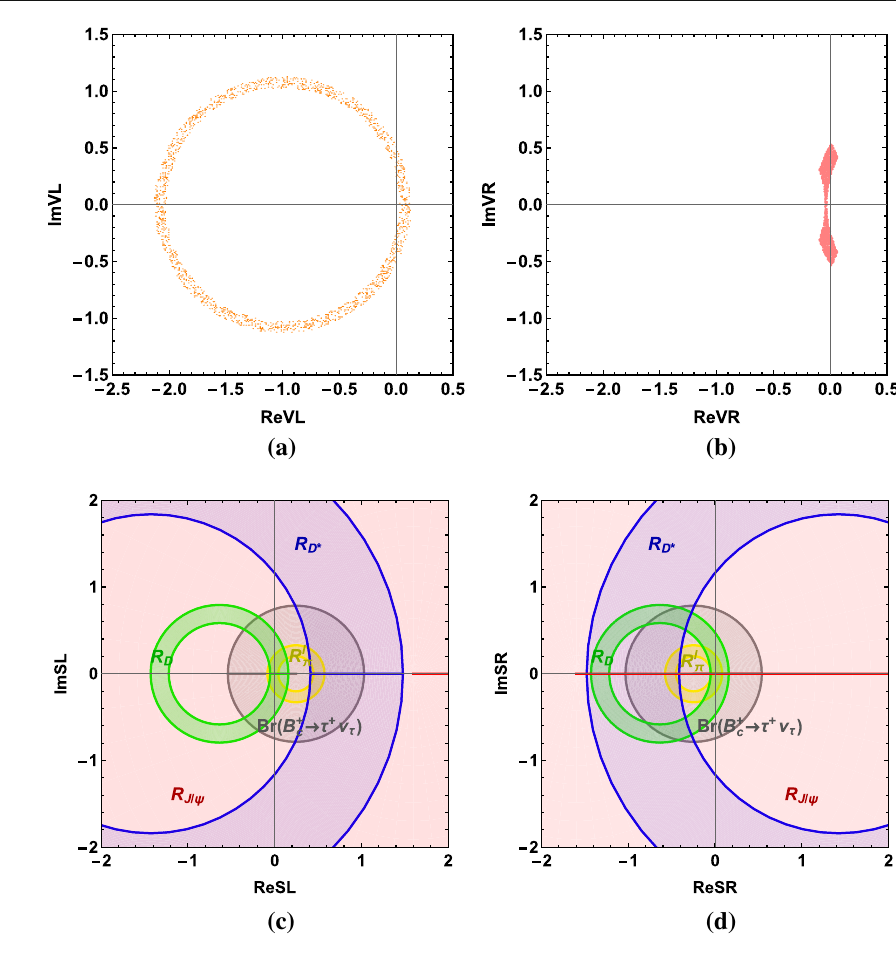
Fig. 1 The constraints on both real and imaginary parts of the NP Wilson coefficients V L ( a ),